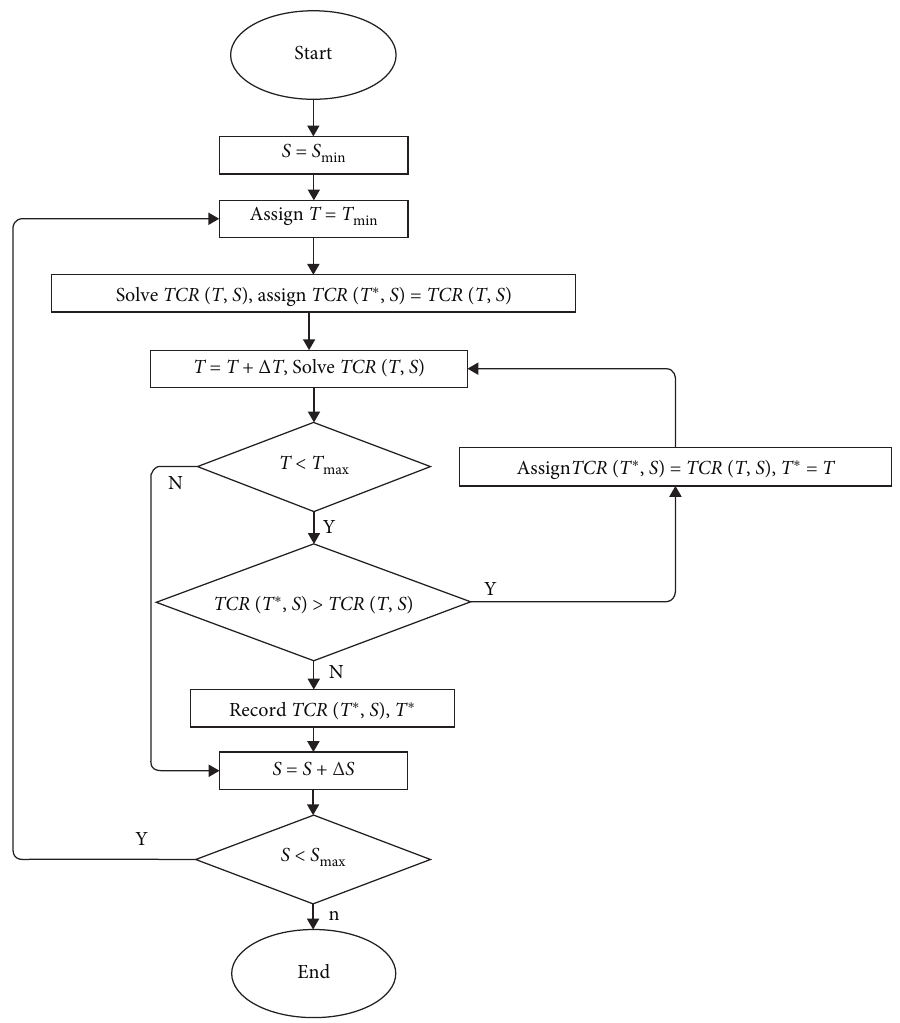
Figure 8: Flow chart of discrete iteration algorithm. Table 1: Related parameters of failure rate distribution, unit: